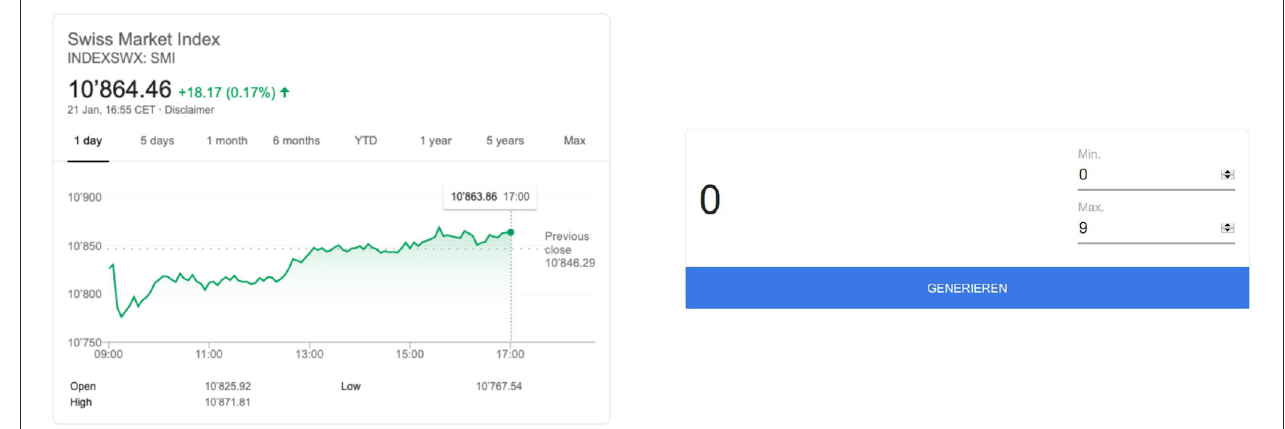
FIGURE 1 | Google widget for SMI/random number.